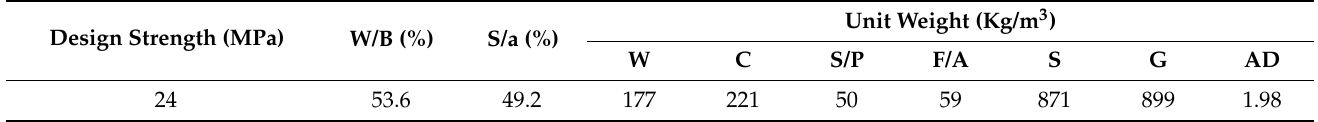
Table 1. Concrete mixture